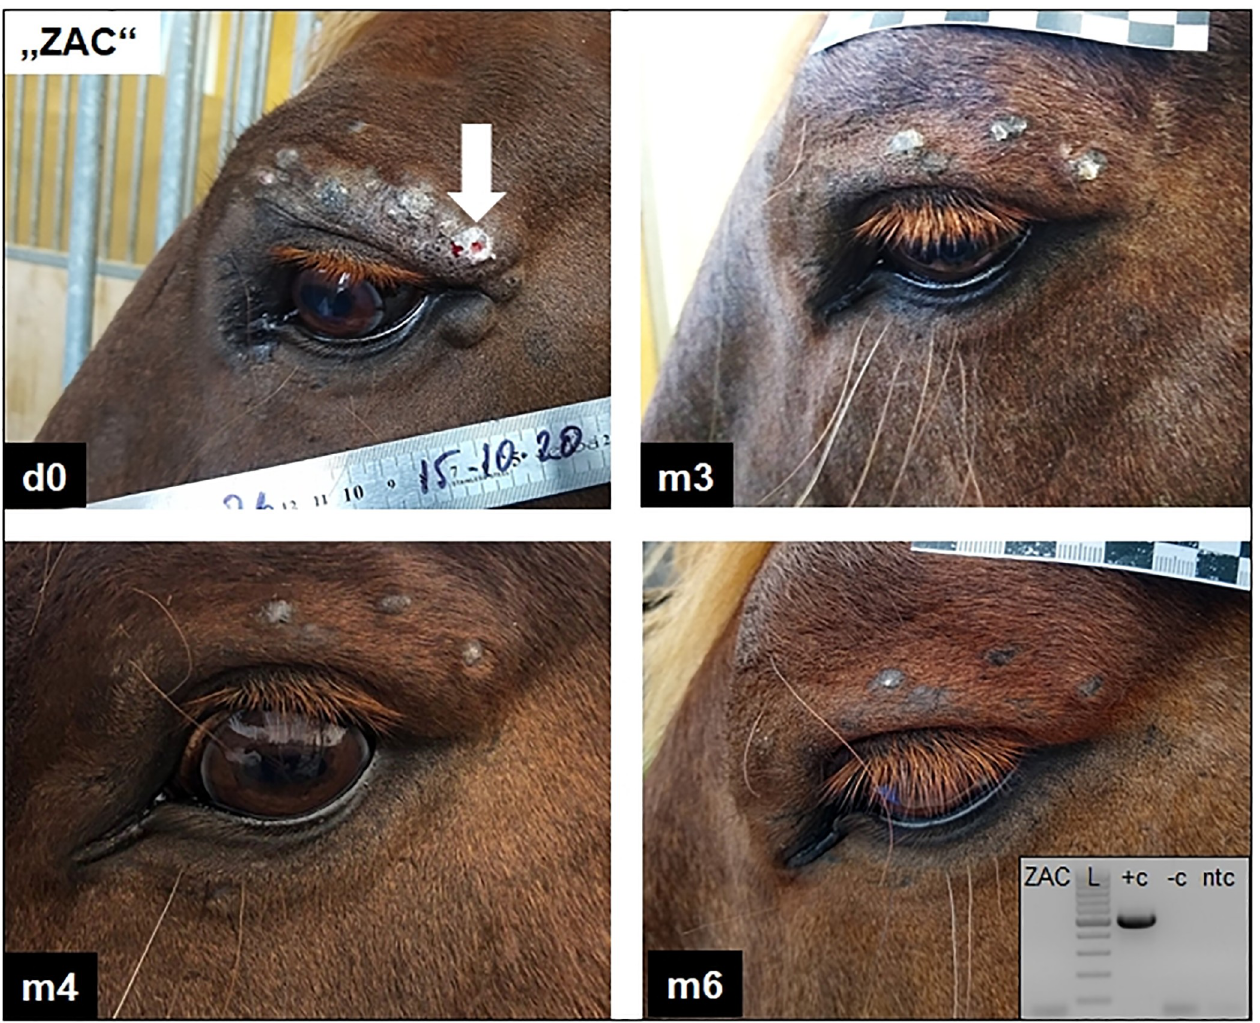
Fig 7. Intratumoural injection with iNSB/E6E7 equ on d0 , d28 , and d86 led to tumour regression and no BPV1 DNA was detectable anymore from the tumour site. A gelding (ZAC) suffering from periocular mixed sarcoids (fibroblastic, nodular and verrucous components) shows complete tumour regression 6 months after intratumoural injections (white arrow indicates injection site) with iNSB/E6E7 equ on days 0, 28 and 86. BPV1 E5 PCR from DNA of hair roots collected from scarified skin during the last visit (month 6) also scored negative (see inserted gel photo; ZAC: patient DNA; L: GeneRuler DNA Ladder mix [ThermoScientific]; +c: sarcoid DNA as positive control: -c: equine intact skin DNA as negative control; ntc: sterile water as no-template control); d0: day 0; m3: month 3; m4: month 4; m6: month 6.